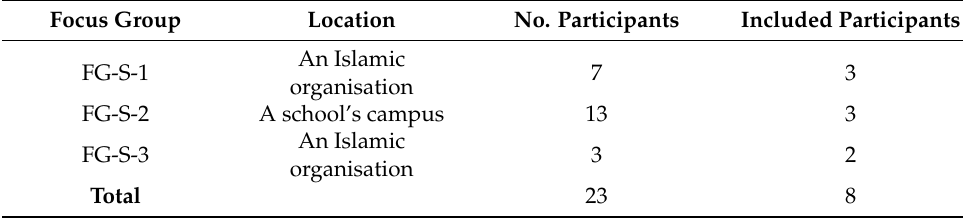
Table 2. Focus Group